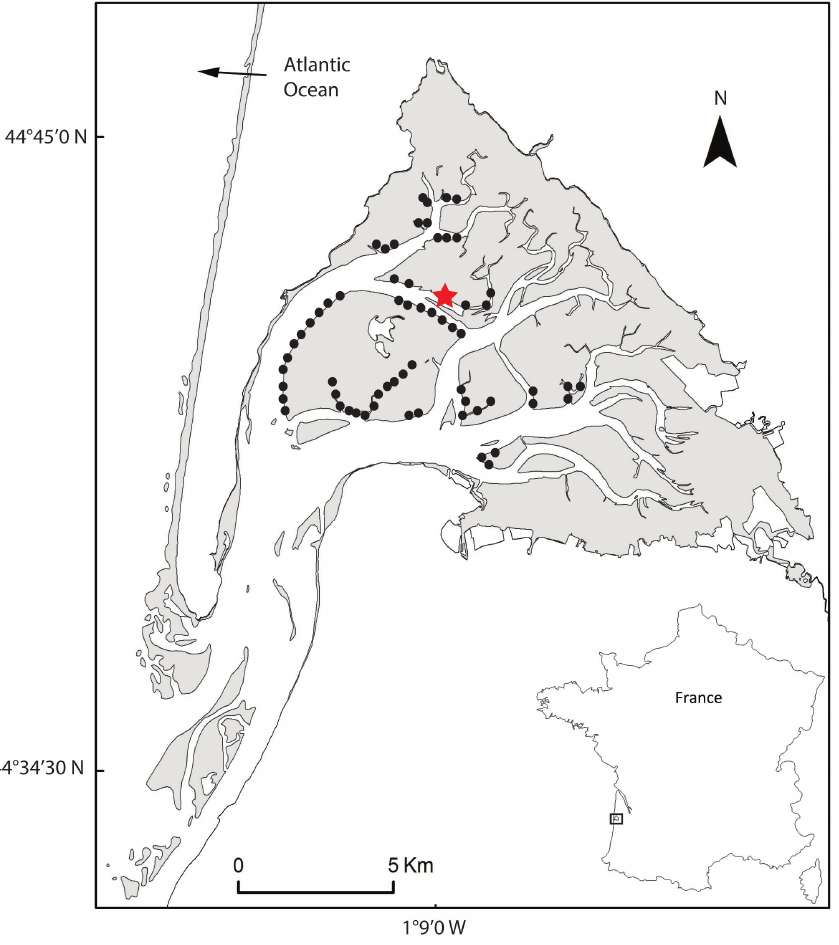
Figure 1. Sampling sites of Marphysa victori sp. n. in Arcachon Bay (Bay of Biscay, western France). Black dots: presence (according to fishermen); red star: type